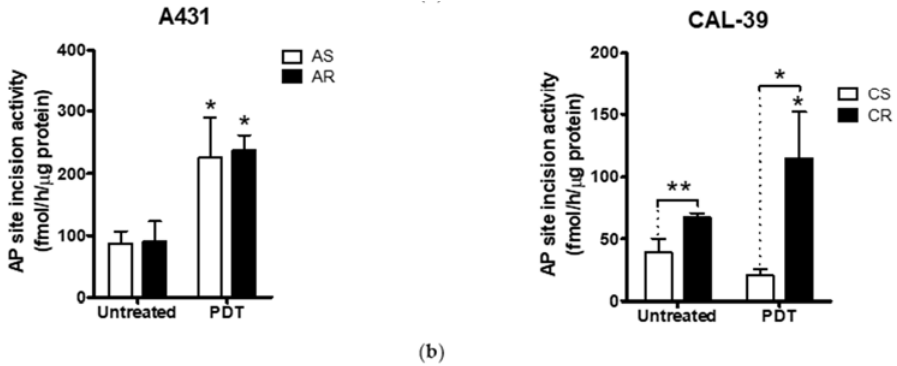
Figure 6. APE1 endonuclease activity assay. ( a ) PhosphorImages of gels with separated products of reaction mediated by protein extracts isolated from the cells before and after PDT. ( b ) Quantification of APE1 endonuclease activity in A-431 and CAL39 cell lines. APE1 activity is expressed as fmol of product per hour per µ g of protein extract isolated from the cells. Asterisks indicate statistical significance of differences between untreated cells and cells that were subjected to PDT, and between sensitive and resistant cells, calculated by the Mann–Whitney test (* p ≤ 0.05, ** p ≤ 0.01).